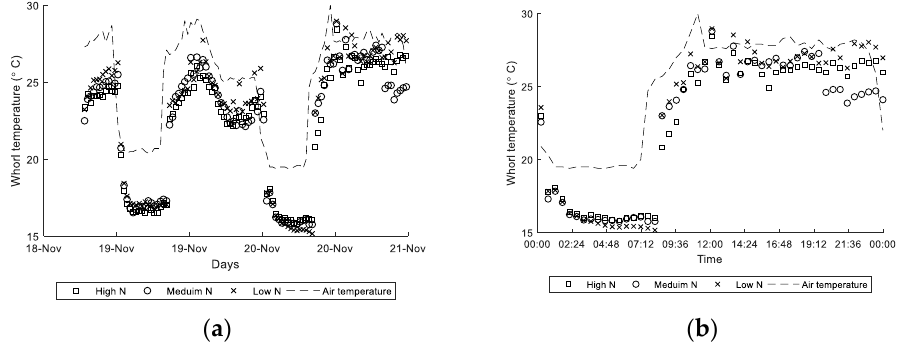
Figure 7. Whorl temperature variations between day and night in November 2015 over ( a ) three days and ( b ) a one-day